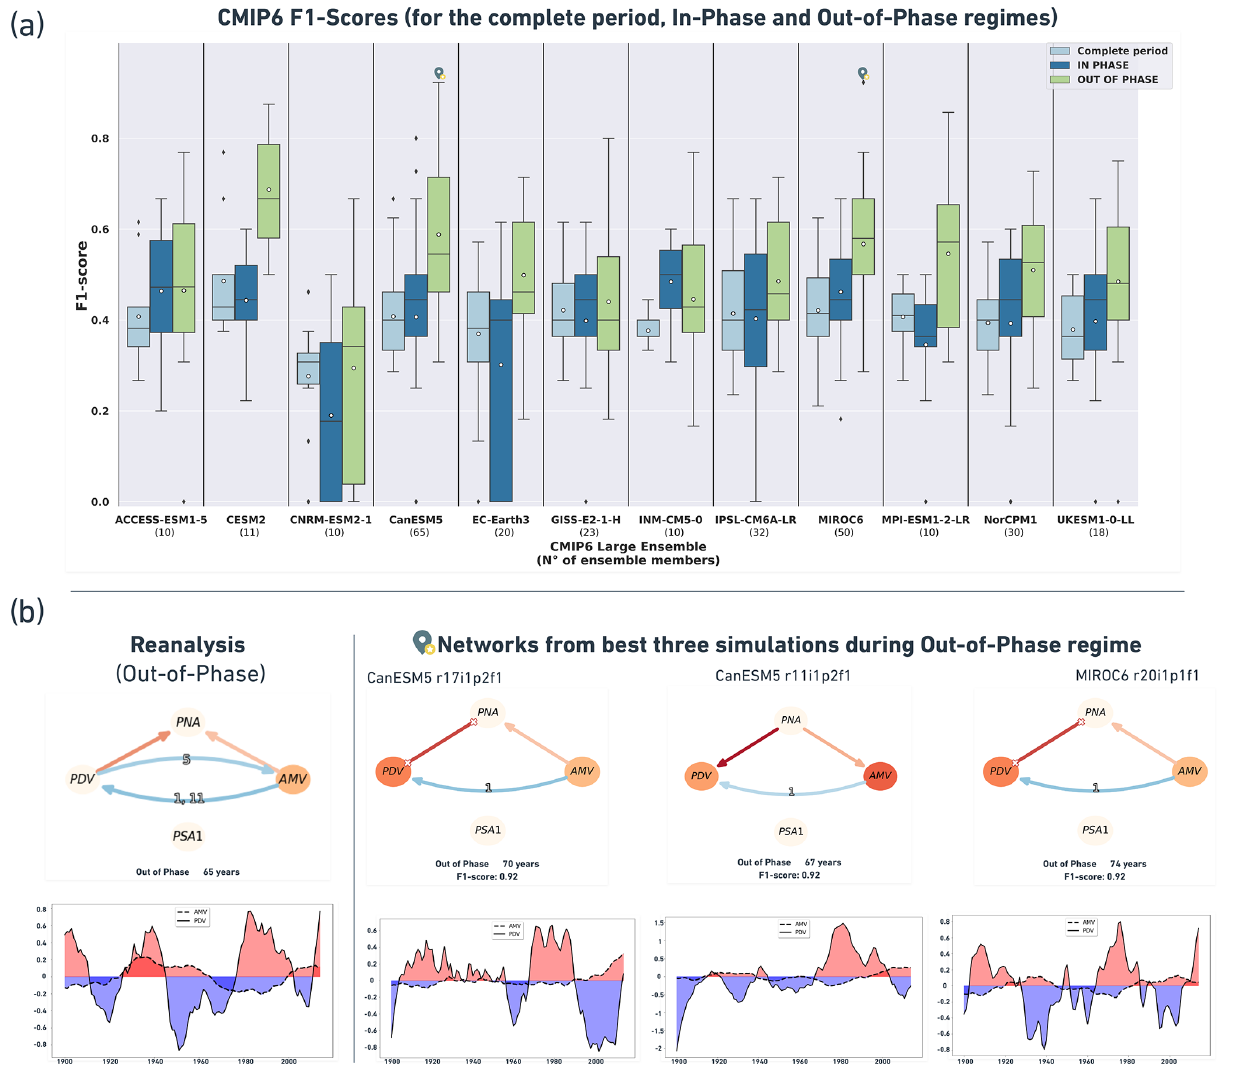
Figure 8. (a) Whisker plot showing the distribution of F 1 scores across the CMIP6 LEs for the causal analysis for the complete period (light-blue boxes), the in-phase regime (dark-blue boxes) and the out-of-phase regime (green boxes). White scatter points denote the mean LE F 1 scores. (b) Reference causal network estimated from reanalysis during the out-of-phase regime (left, with low-pass AMV and PDV time series below) compared to networks and time series from three CMIP6 simulations (right, with simulated low-pass AMV and PDV time series below each network) with the best network similarity, i.e., the highest F 1